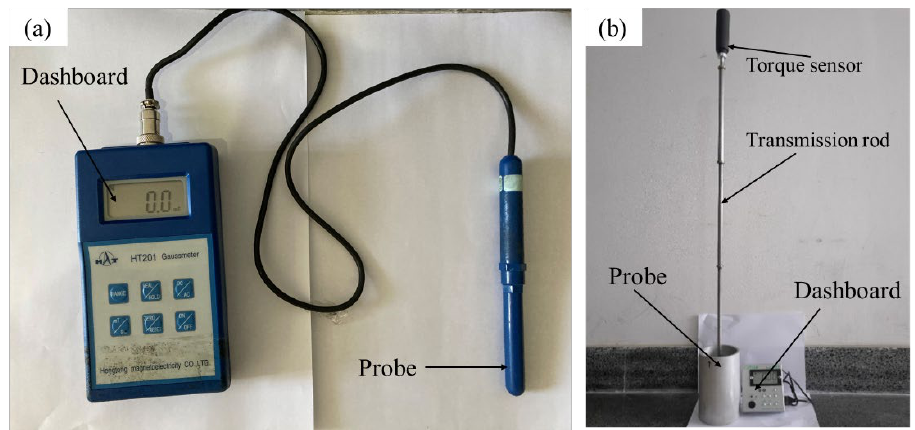
Figure 3. Magnetic field measurement instruments: ( a ) HT-201 Gaussmeter, ( b ) CEDARDIS-RL elec- tromagnetic torque meter.